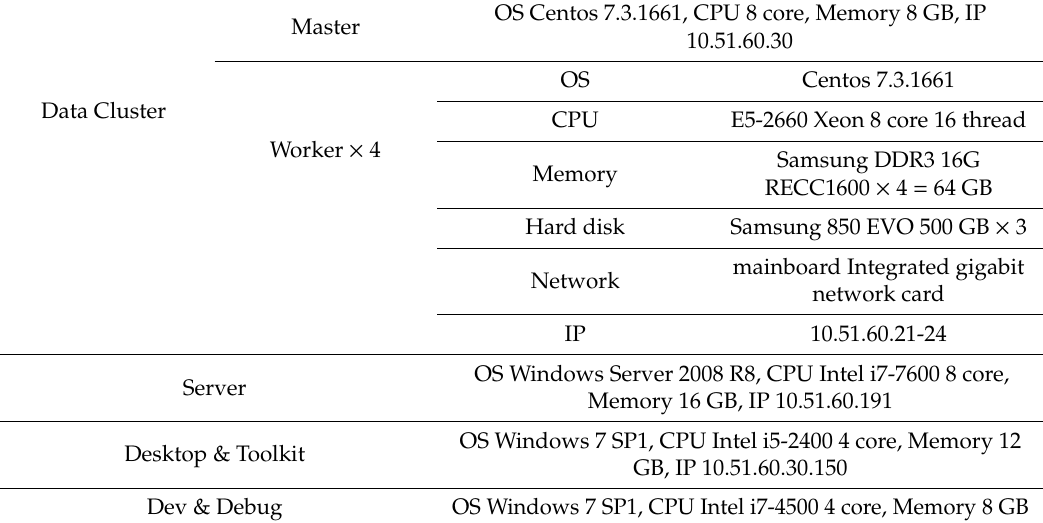
Table 2. BiGeo hardware